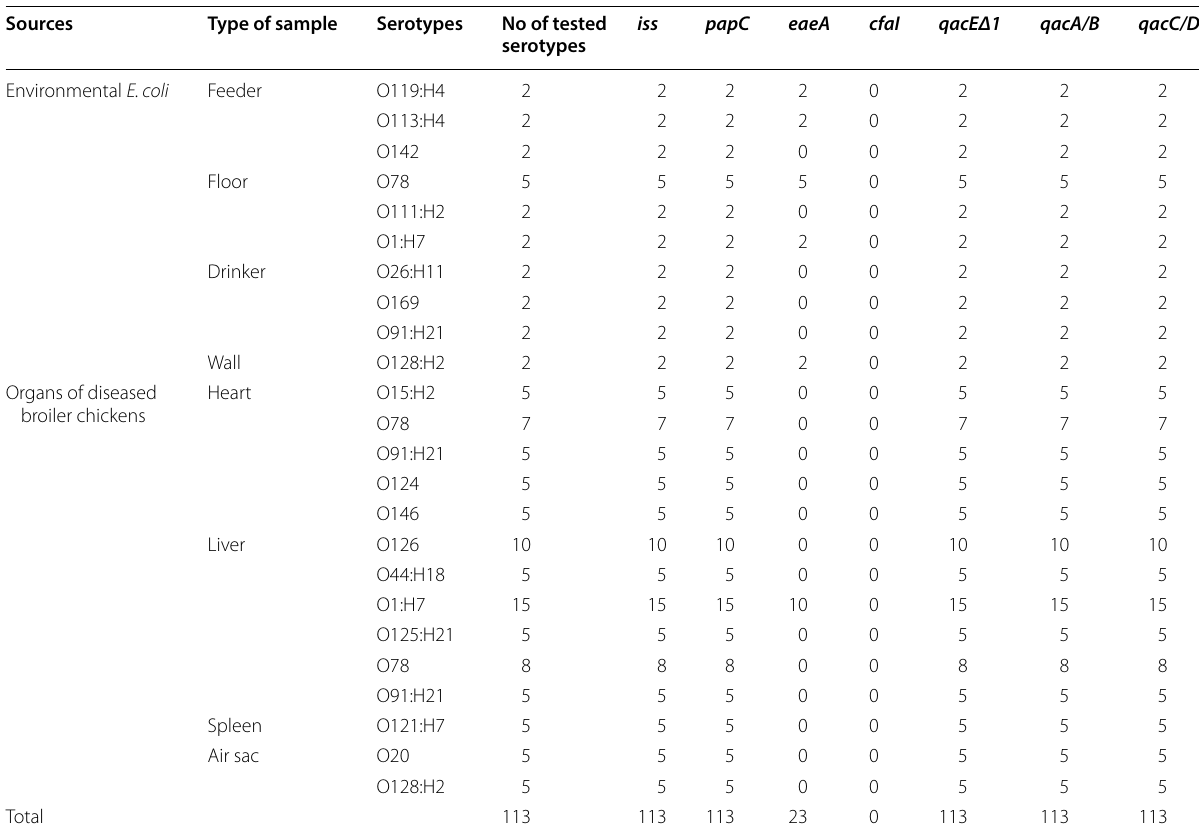
Table 5 Prevalence of virulence genes and QACs resistance genes between the isolated E. coli serotypes